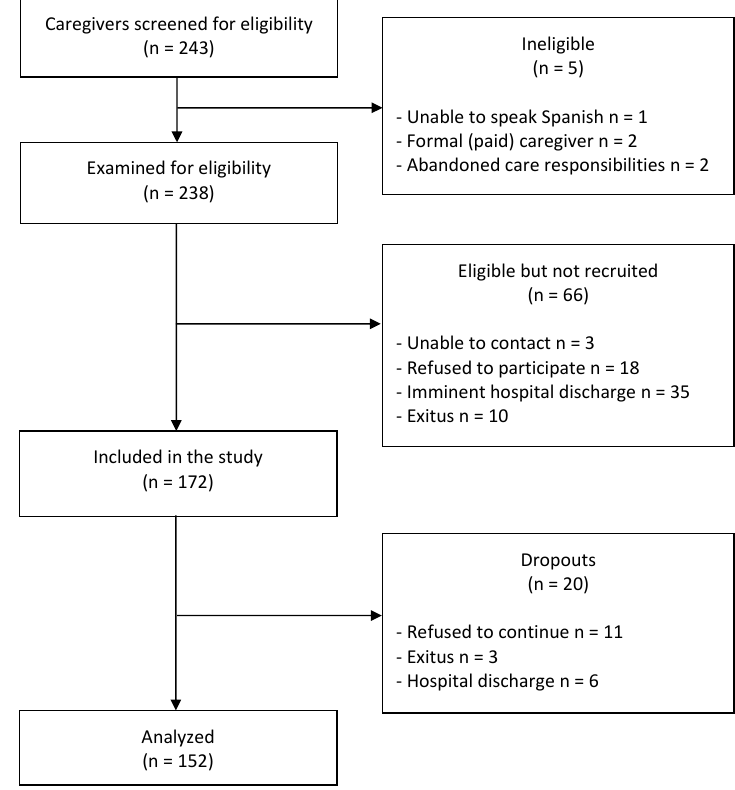
Figure 1. Flow diagram.